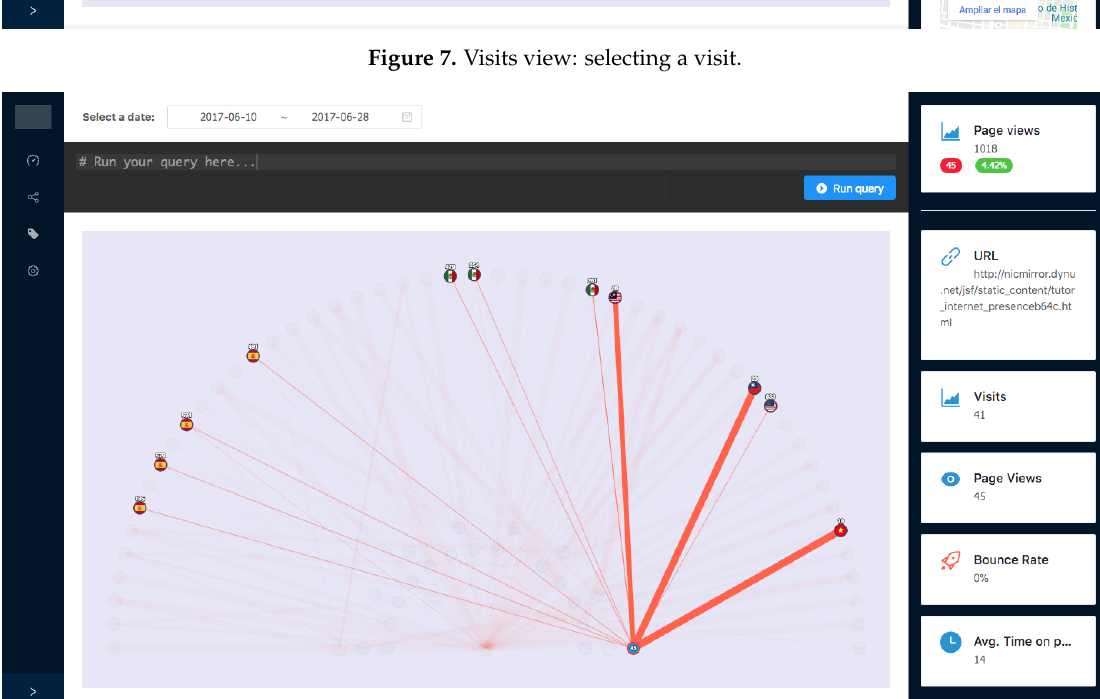
Figure 8. Visits view: selecting a